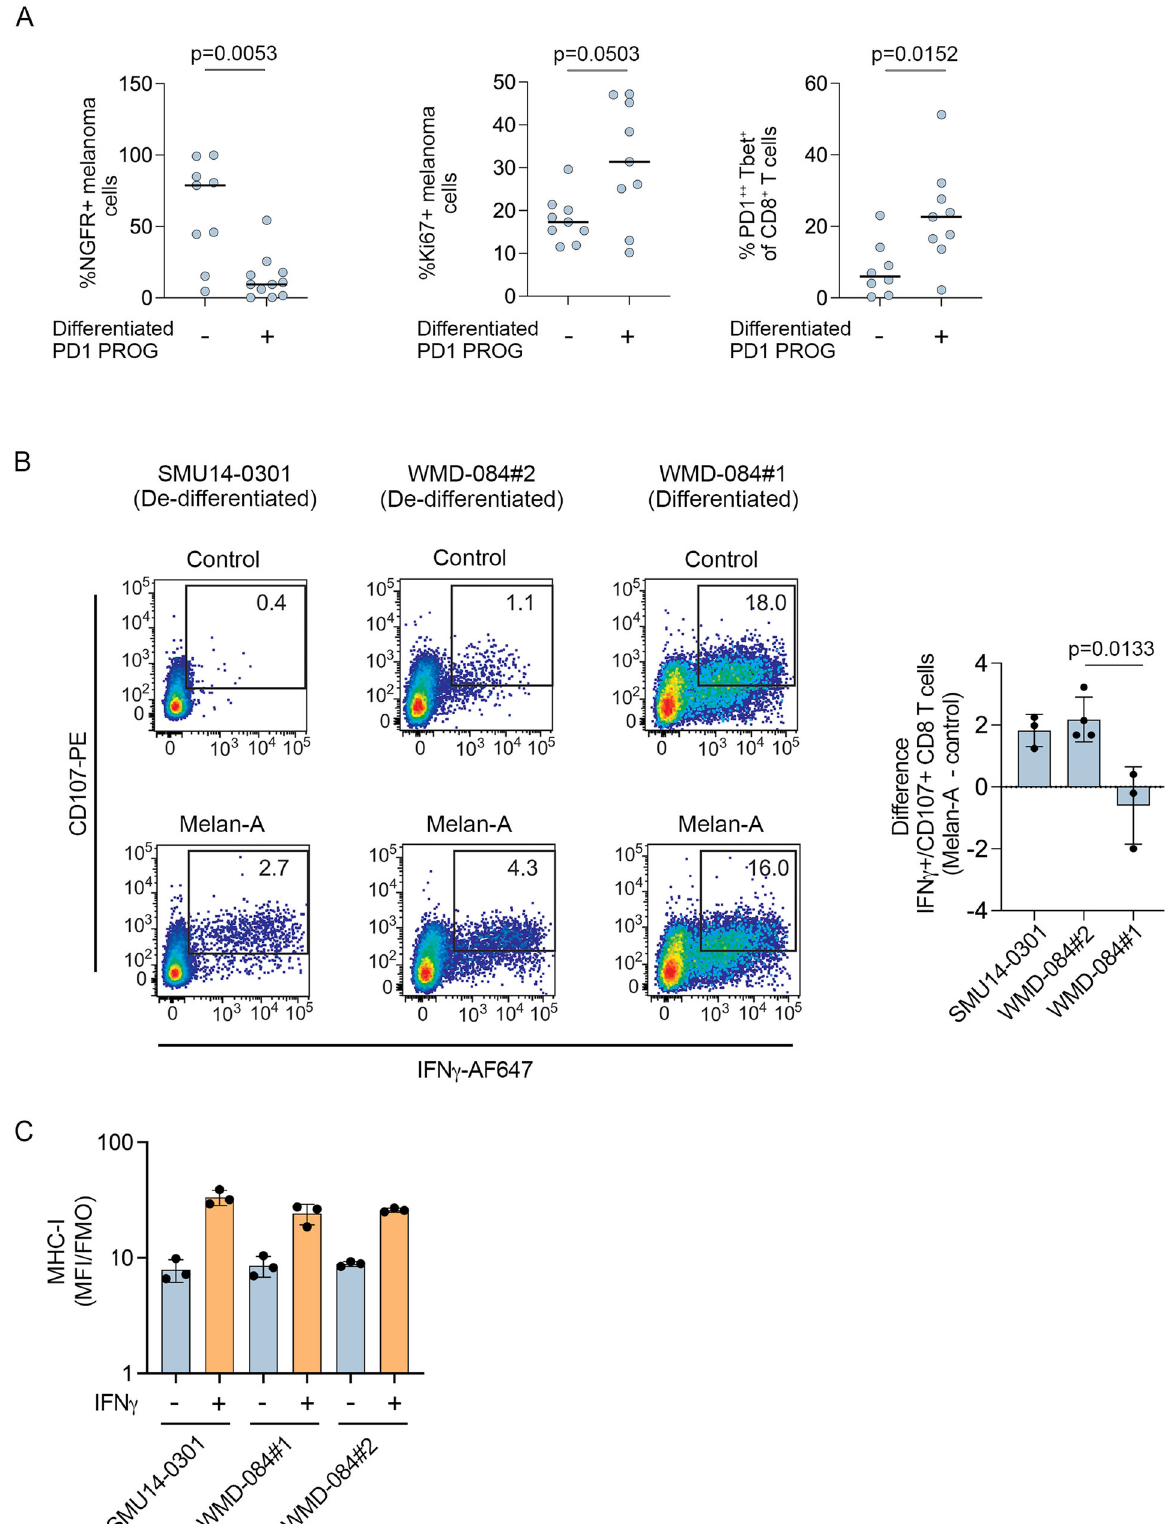
PD-L2, and galectin 9. Third, a smaller subset of PD1 inhibitor-resistant melanomas (5/22; 23%) show loss-of-function mutations in the PTEN gene, and this was associated with a paucity of immune cells and brain metastases. In melanoma, loss of PTEN is associated with